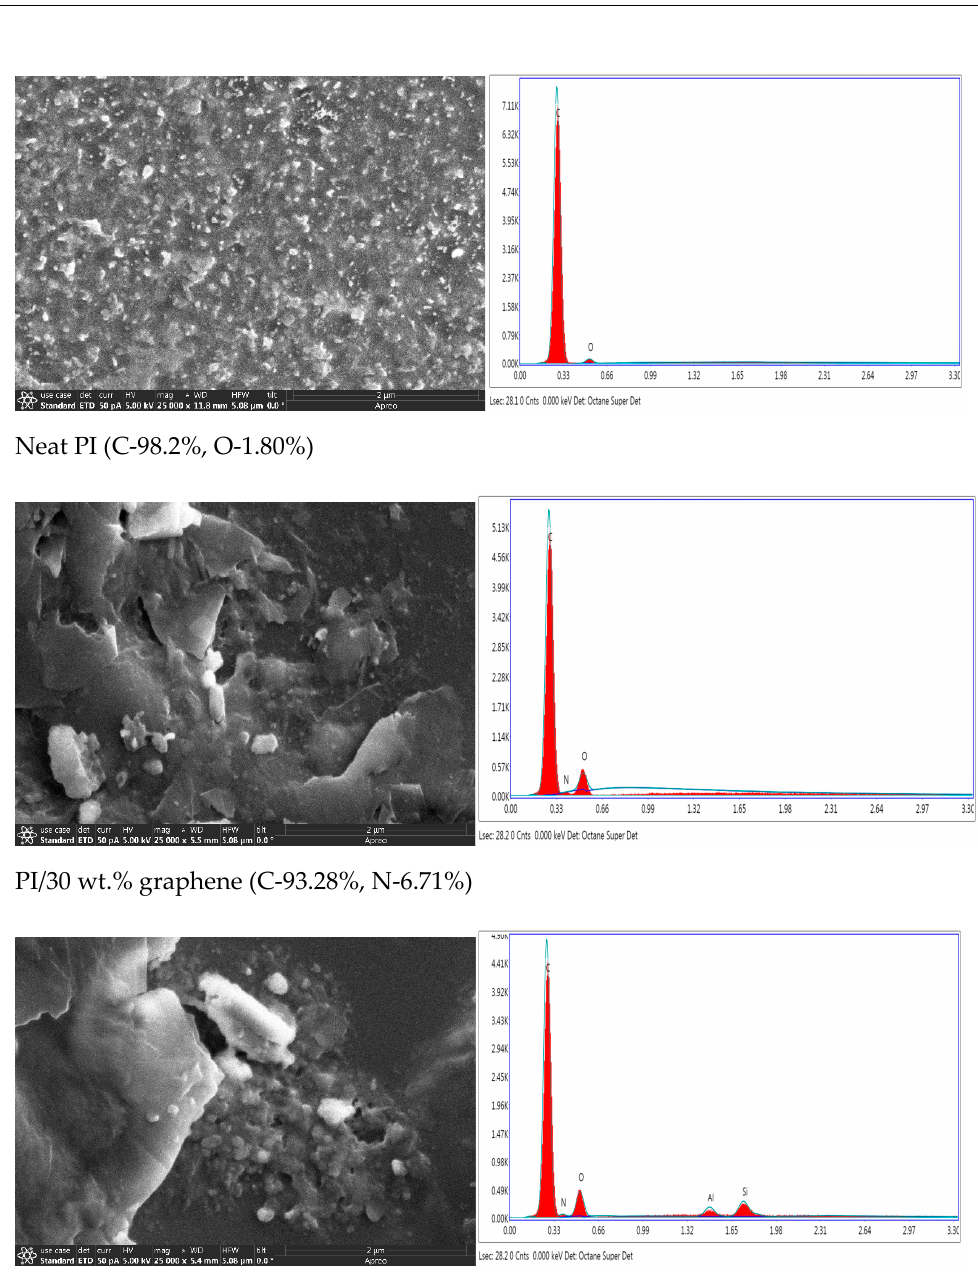
Figure 1. SEM images with EDAX for (top) neat PI, (middle) PI-NGS-0 vol.% clay, and (bottom) PI-NGS-9 vol.% clay, at a magnification of ×25,000.